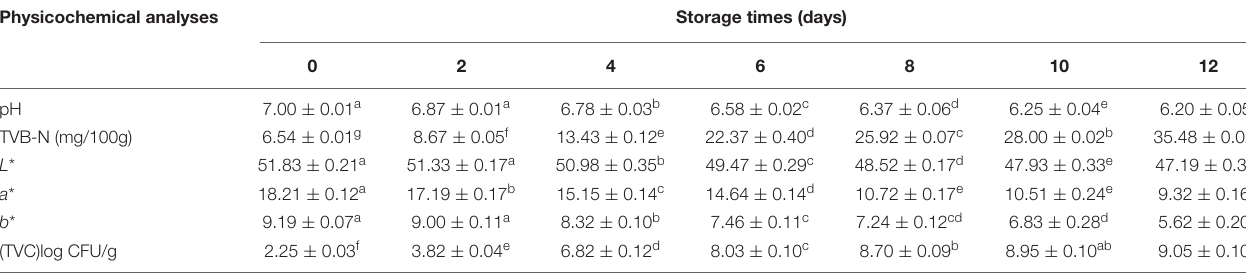
TABLE 1 | Total viable counts, pH, TVB-N, and color changes in low-temperature sausage during storage. Physicochemical